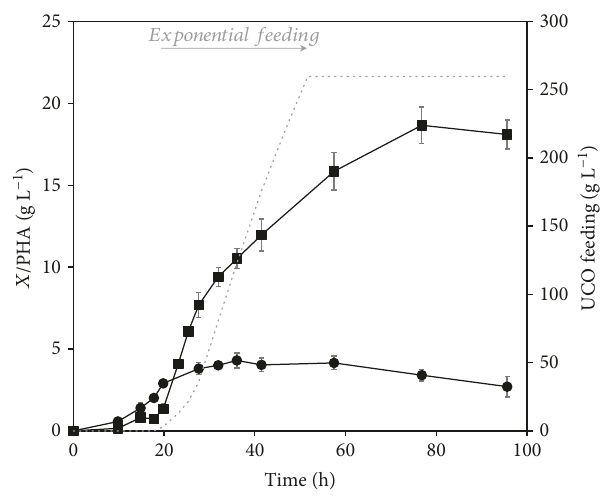
Figure 1: Production of PHA ( ■ ) and active biomass (X) ( ● ) by C. necator cultivated in fed-batch mode with an exponential feeding pro fi le (UCO